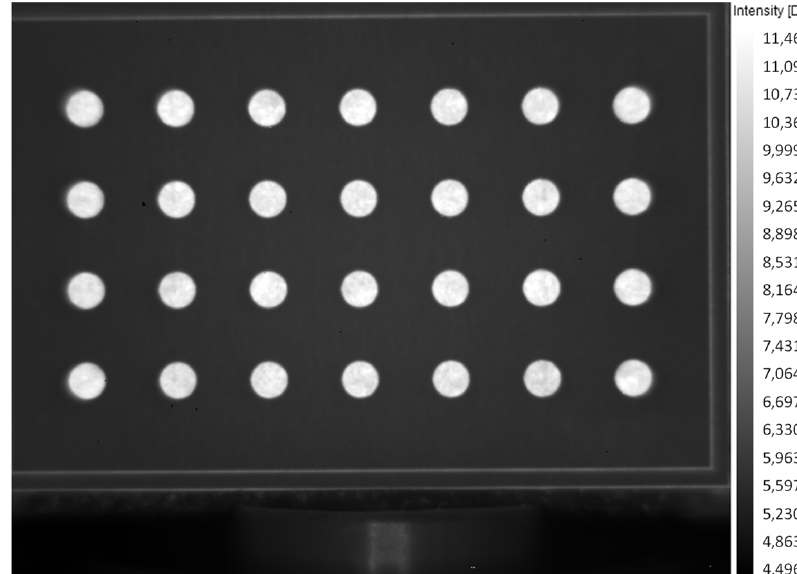
Figure 2. IR image of the calibration grid (units are in digital levels, DL).